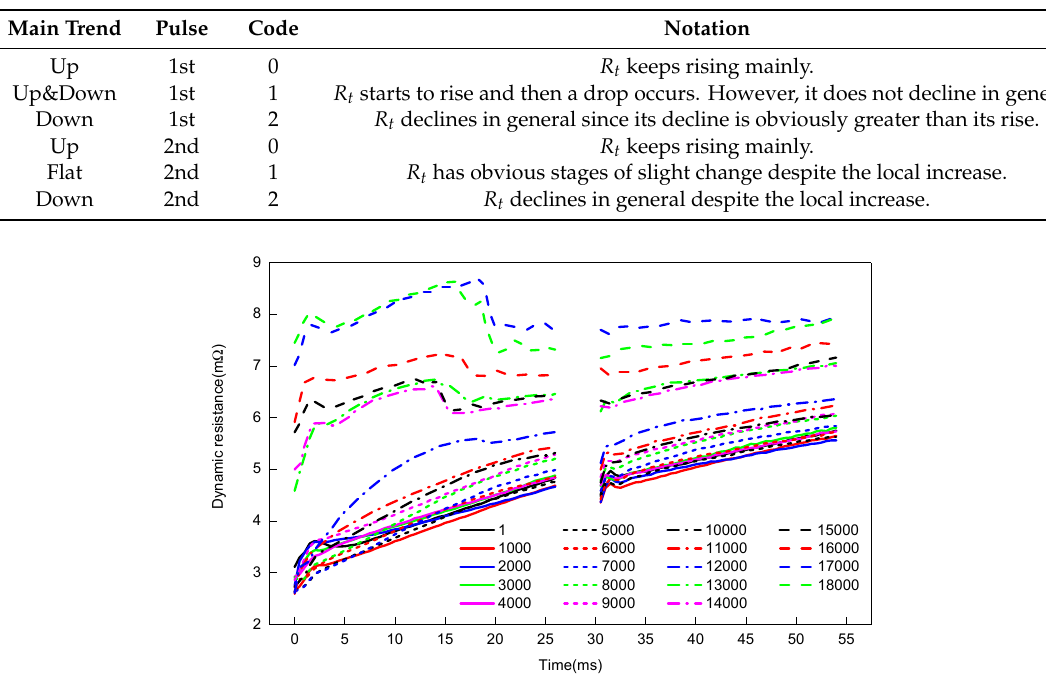
Table 3. Notation of dynamic resistance profile.